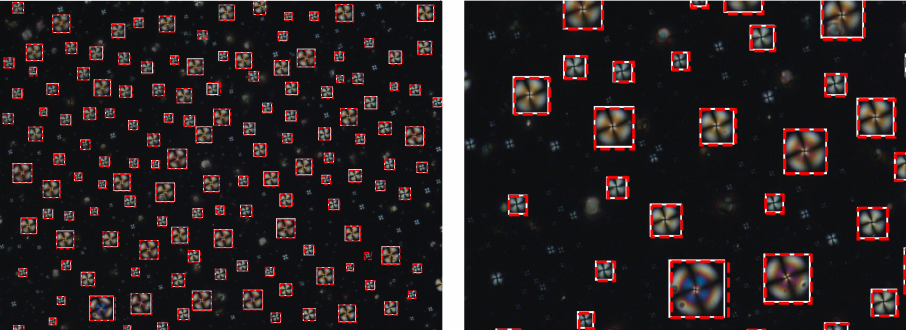
Figure 8. Droplet Bounding Boxes. Ground truth bounding boxes are shown in white whereas YOLO detection are shown in red. ( Left ) whole Frame; ( Right ) zoomed in section.